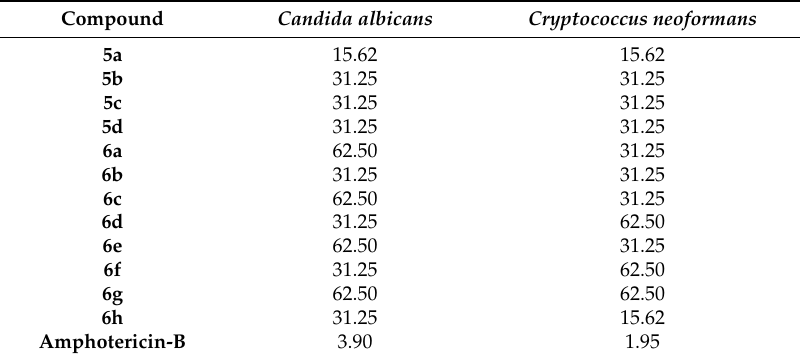
Table 3. Minimum inhibitory concentration (MIC, µ g/mL) of 5a – d and 6a – h against fungal